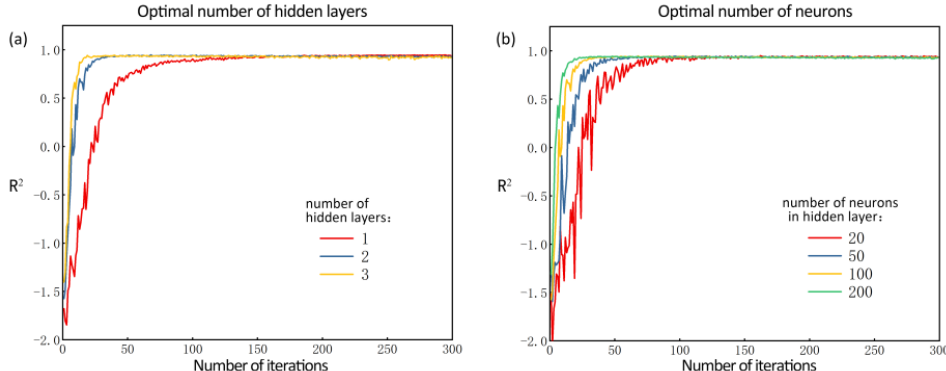
Figure 8. Debugging of optimal parameters of BP